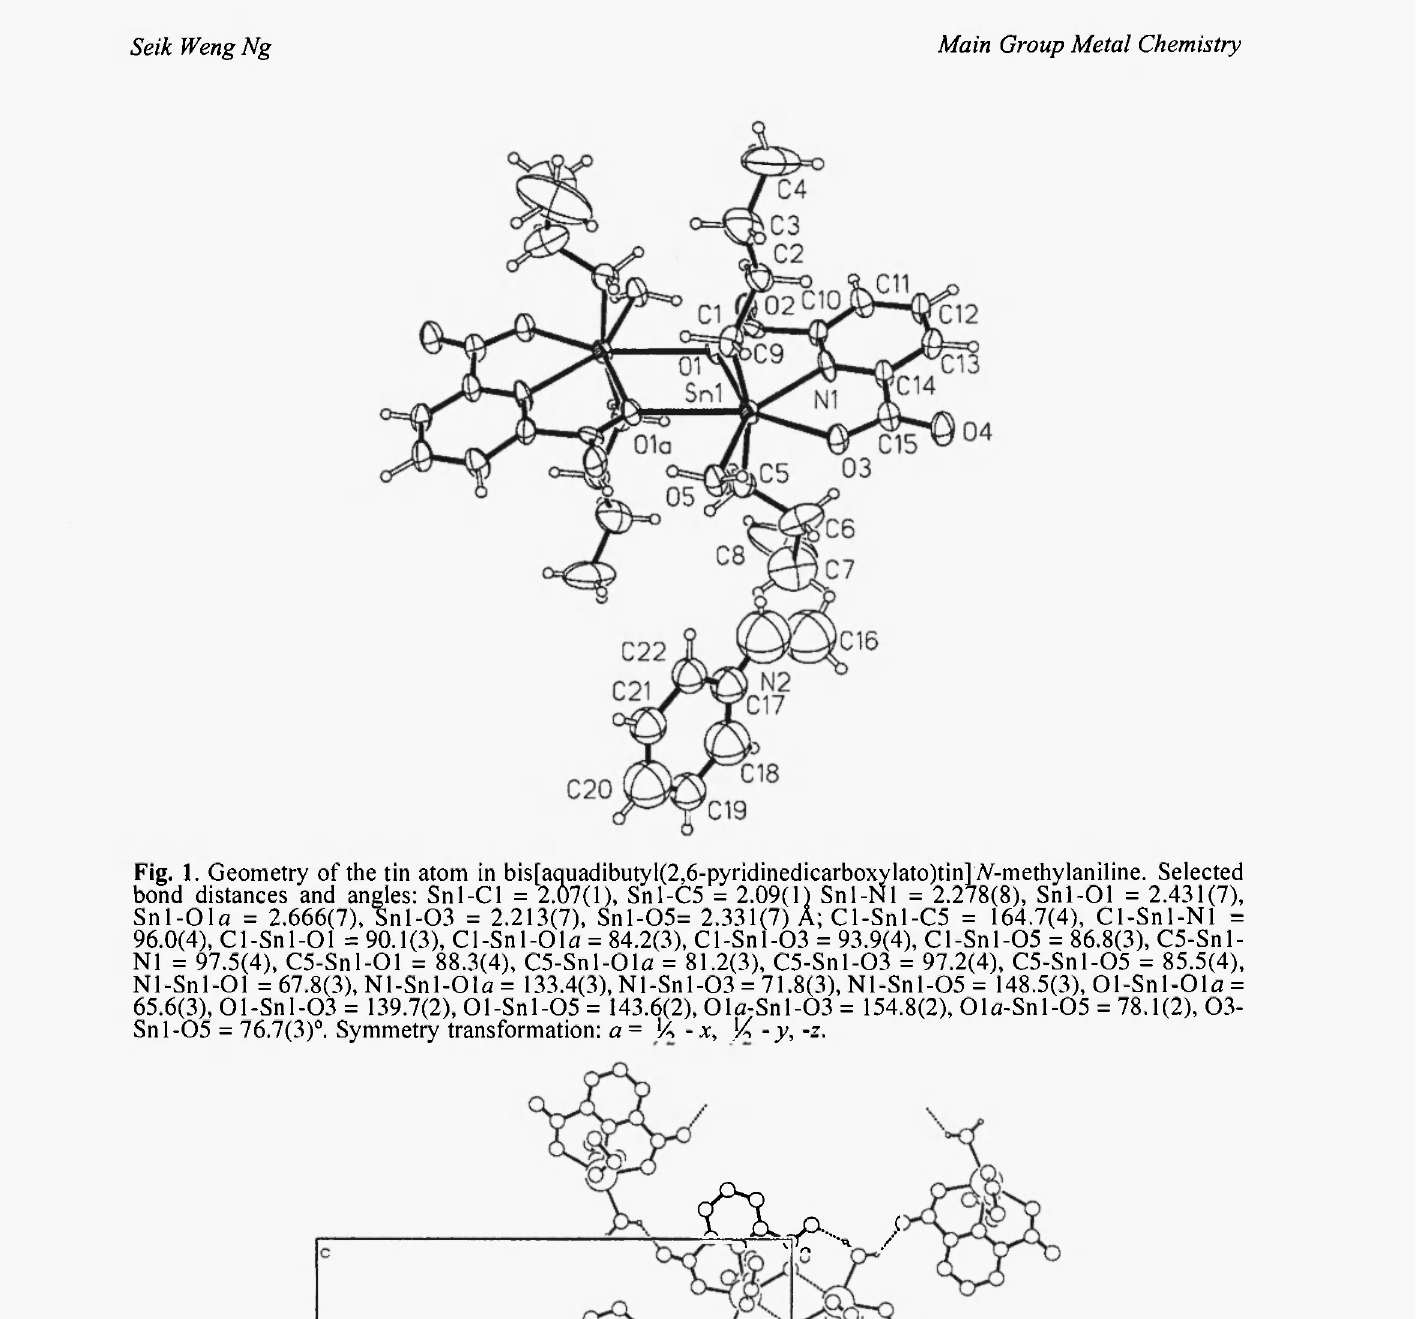
Fig. 2. Hydrogen bonds linking the bis[aquadibutyl(2,6-pyridinedicarboxylato)tin] molecules [05 Ό2' = 2.646(9), 05 04" = 2.729(9) Ä] viewed along the α-axis. Symmetry transformation: ' = y 2 ' *> Yl ' 2 Κ-*·- /i+y^-'A -z; In the yV-methylaniline solvate, the coordinated water of the dinuclear molecule forms hydrogen bonds with adjacent molecules [Ο Ο = 2.729(9) A], The hydrogen bonding interactions furnish a layer structure (Fig. 2). The layers are separated by a distance equal to half the α-axis (i.e., 8.61 A), and